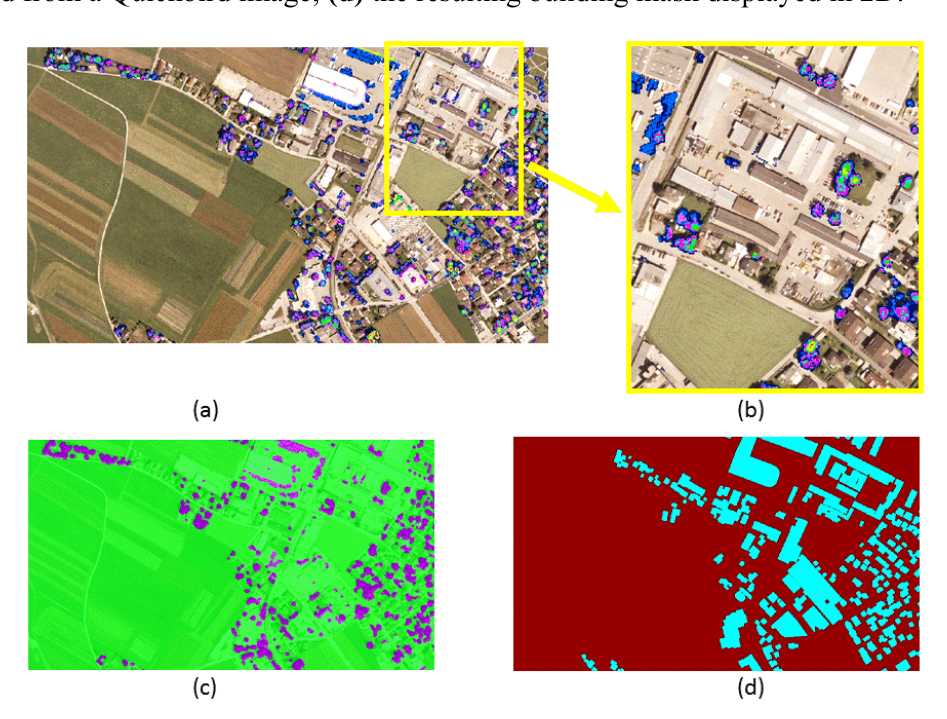
Figure 3. LiDAR and optical data are routinely combined in many